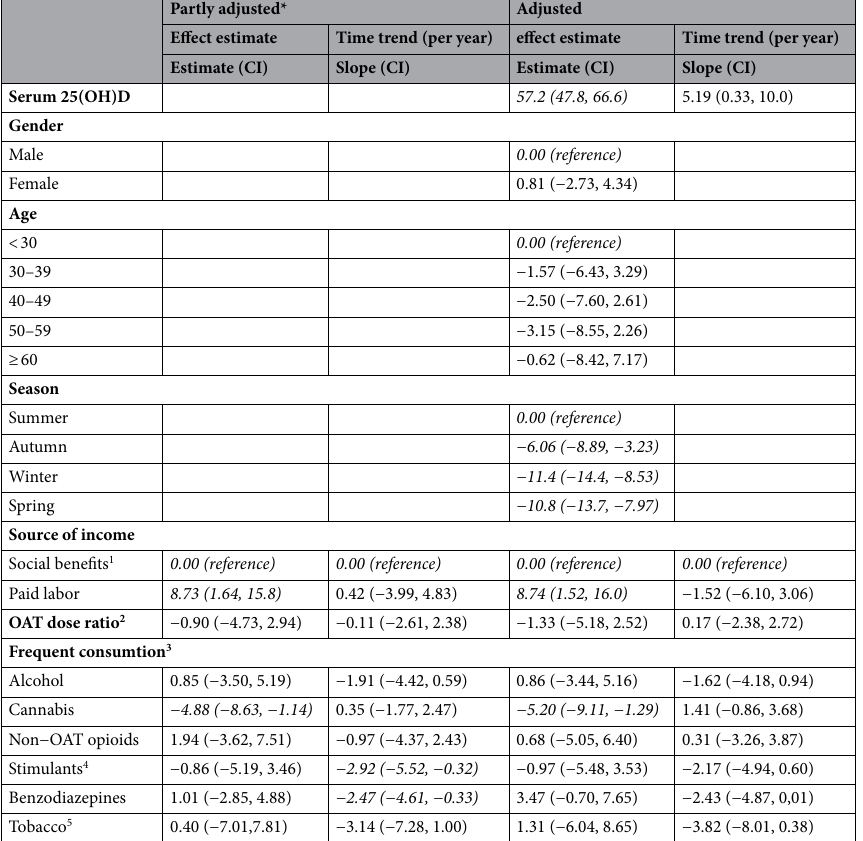
Table 3. The table displays the results of a linear mixed model (restricted maximum likelihood regression) estimating associations of serum 25(OH)D concentration (nmol/l) with sociodemographic and clinical predictor variables at baseline (effect estimates), as well as the impact of predictors on changes in serum vitamin D concentrations over time (time trends per year). Significant results are shown in italics ( p < 0.05). CI, 95% confidence interval. *Adjusted for gender and age. 1 Social benefits include disability, disease and unemployment benefits and work assessment allowance. 2 The prescribed daily dosage of opioid agonist divided by the WHO mean recommended dosage (90 mg for methadone, 18 mg for buprenorphine). In this variable, zero represents no prescribed OAT medication. 3 Self-reported consumption of a substance at a minimum weekly basis during the 12 months prior to the first assessment. 4 Amphetamine, methamphetamine and cocaine. 5 Self-reported tobacco use (smoking or snuff) on a minimum weekly basis during the 12 months prior to the first health